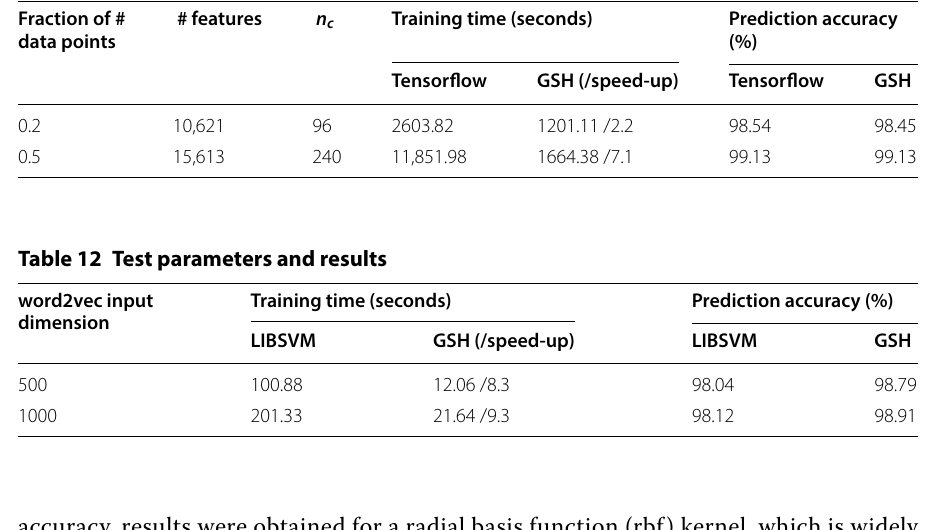
Table 11 Test parameters and results